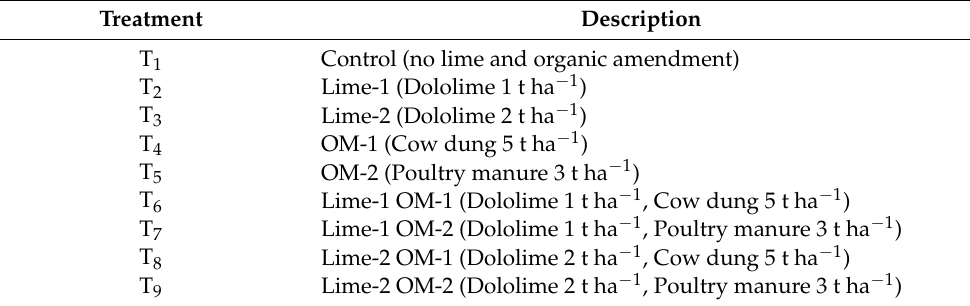
Table 1. List of the treatments used in the study with description.